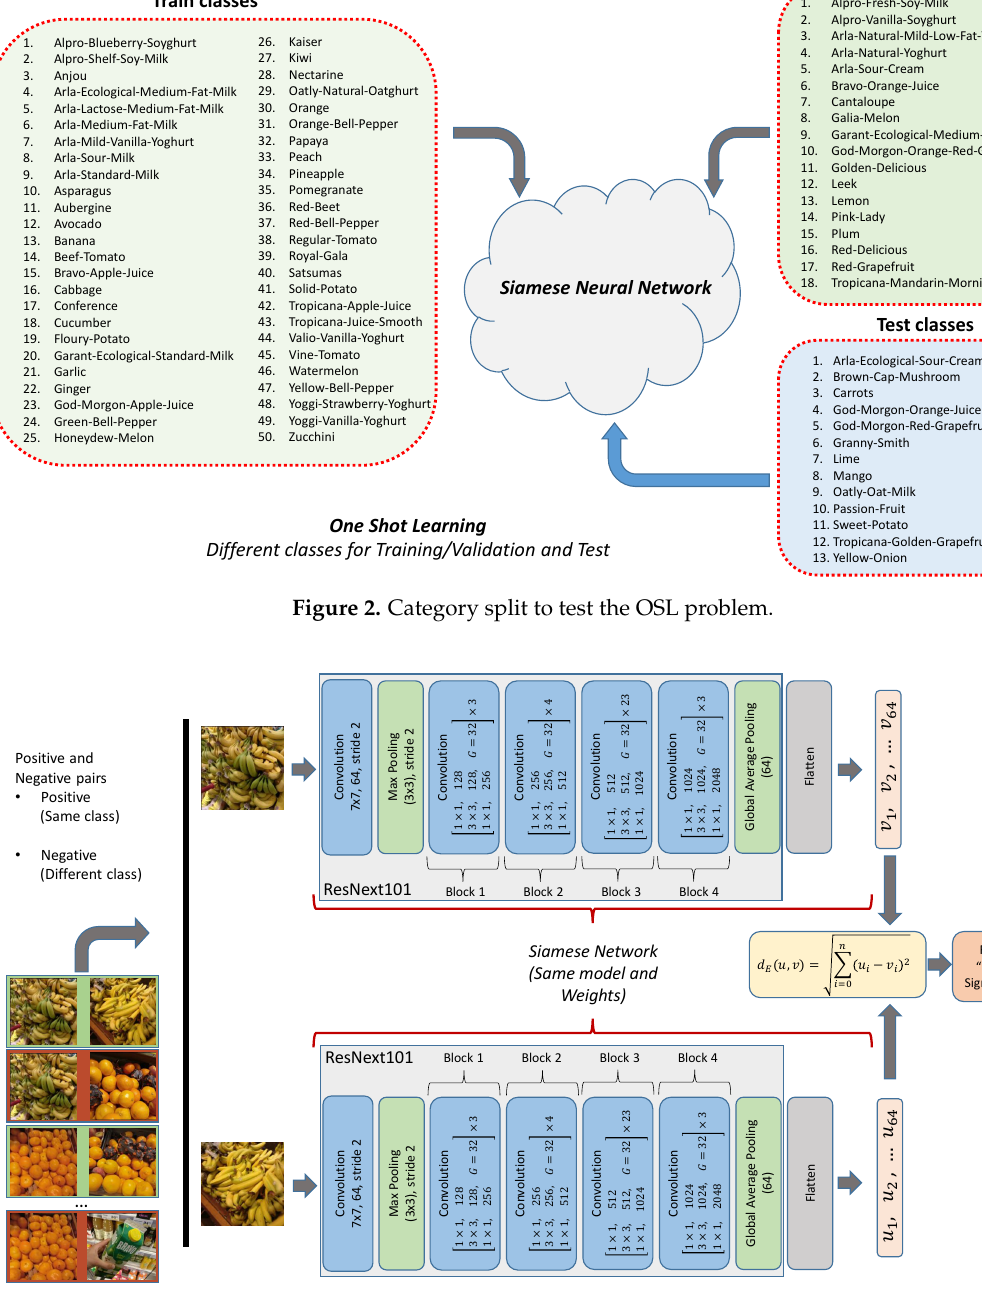
Figure 3. First approach: Siamese net with